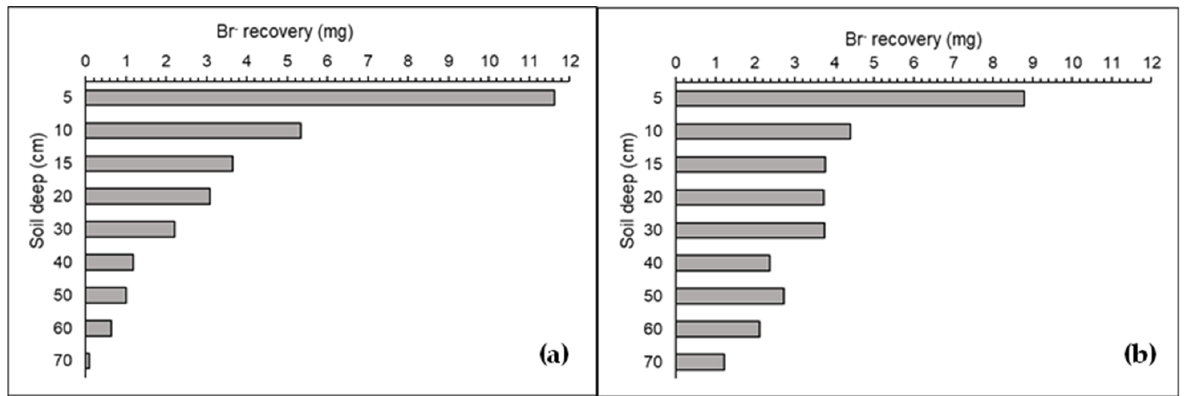
Figure 4. Br − recovery (g) in the soil profile on year 1 ( a ) and year 2 ( b ) following simulation of dairy cow urinations using potassium bromide (KBr) solution.